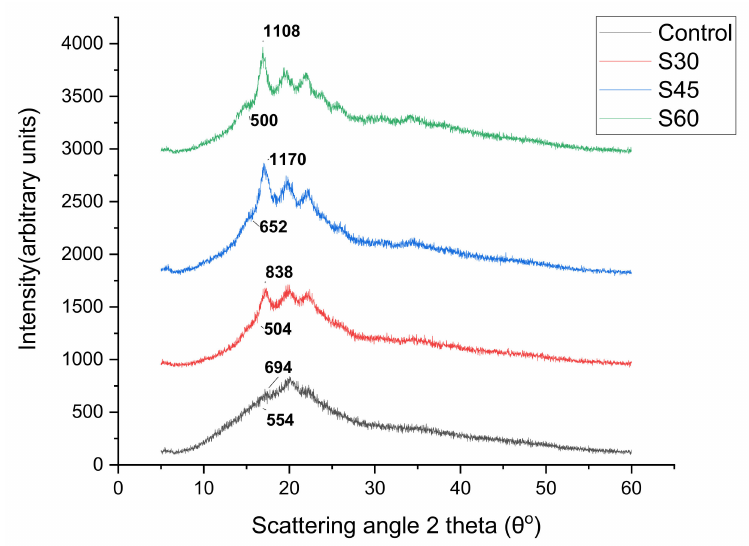
Figure 10. XRD of sorbitol plasticized and unplasticized CS